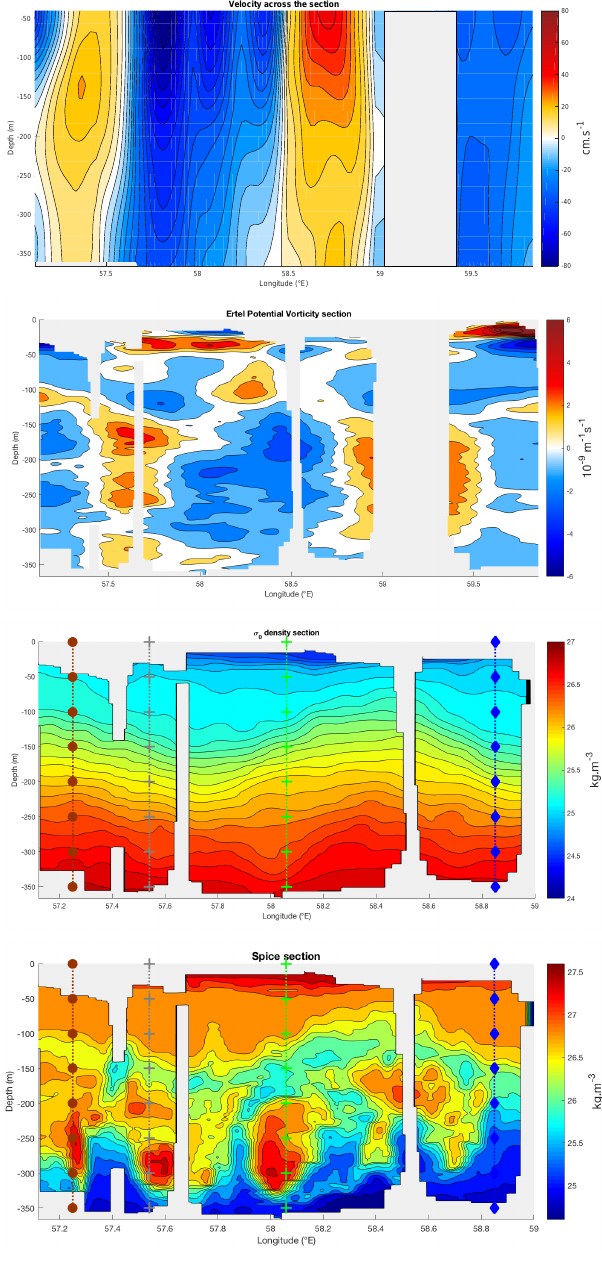
Figure 5. SO sections of the eddies, south of Ra’s Al Hadd from the surface down to 350m depth. Measurements and derived quan- tities are VM-ADCP velocities, positive towards the north; the Ertel potential vorticity anomaly is derived from VM-ADCP and SeaSoar fields; σ 0 potential density and spice. Profiles sampled in Fig. 7. Top panel: brown circle: cascading PGW outflow; grey cross: 57.5 ◦ E lens; green cross: 58 ◦ E lens; blue diamond: profile out of the salty